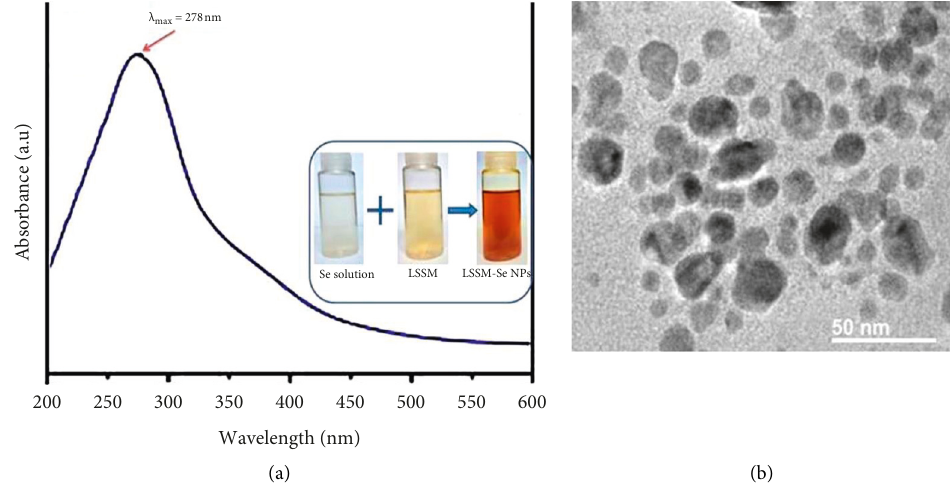
Figure 1: Color indicators and UV-vis spectrum (a) and TEM physiognomy (b) of mediated Se NPs with Lepidium sativum mucilage